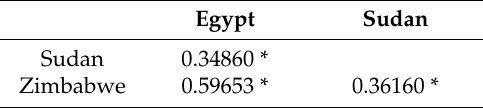
Table 3. Population pairwise Φ